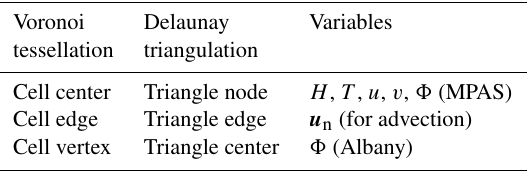
Table 1. Correspondence between the MPAS Voronoi tessellation and its dual Delaunay triangulation used by Albany. Key MALI variables that are natively found at each location are listed. Note that variables are interpolated from one location to another as re- quired for various